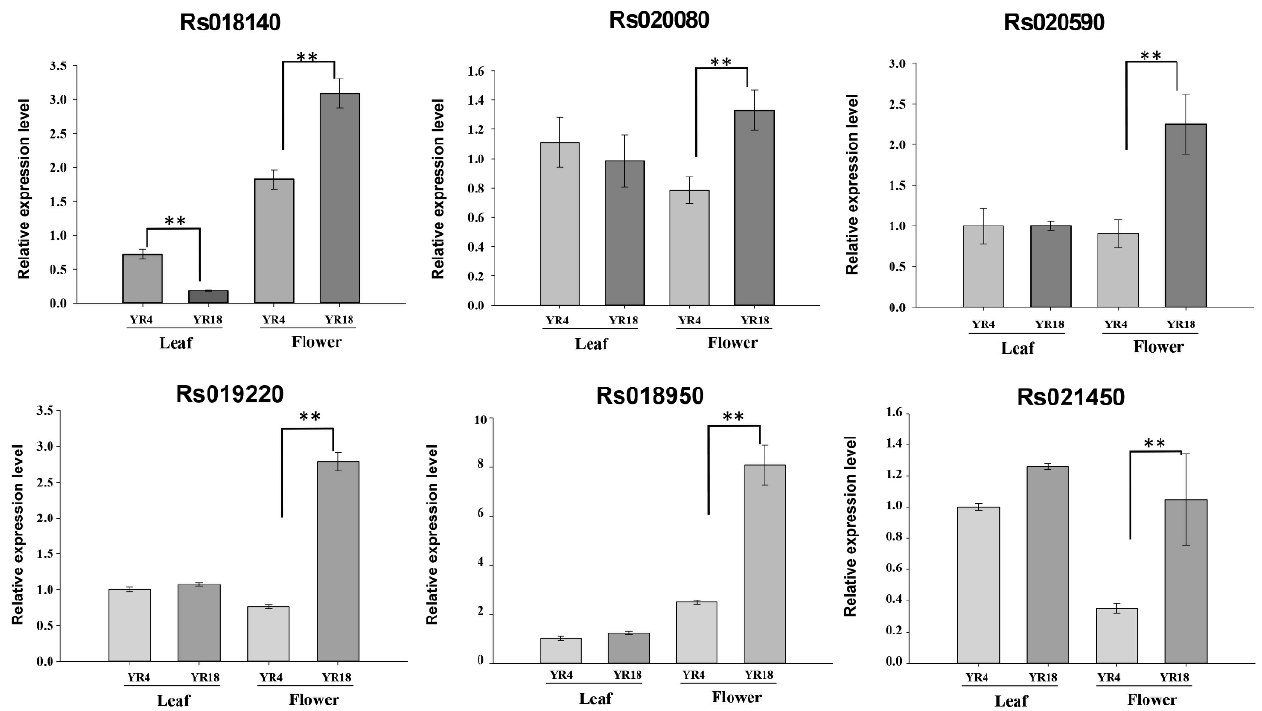
Figure 5. Expression levels of six candidate genes in ‘YR4’ and ‘YR18’ leaves and flowers. Error bars indicate the standard error of the mean of three biological replicates ( n = 5), and asterisks indicate a significant difference between the ‘YR4’ and ‘YR18’ lines based on a t -test (independent). Double asterisks (**) indicates p < 0.01.